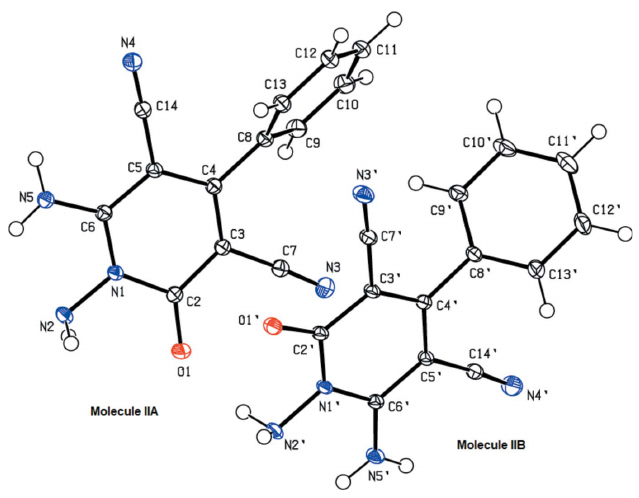
Figure 2 The molecular structure of compound (II). Displacement ellipsoids are drawn at the 50% probability level.